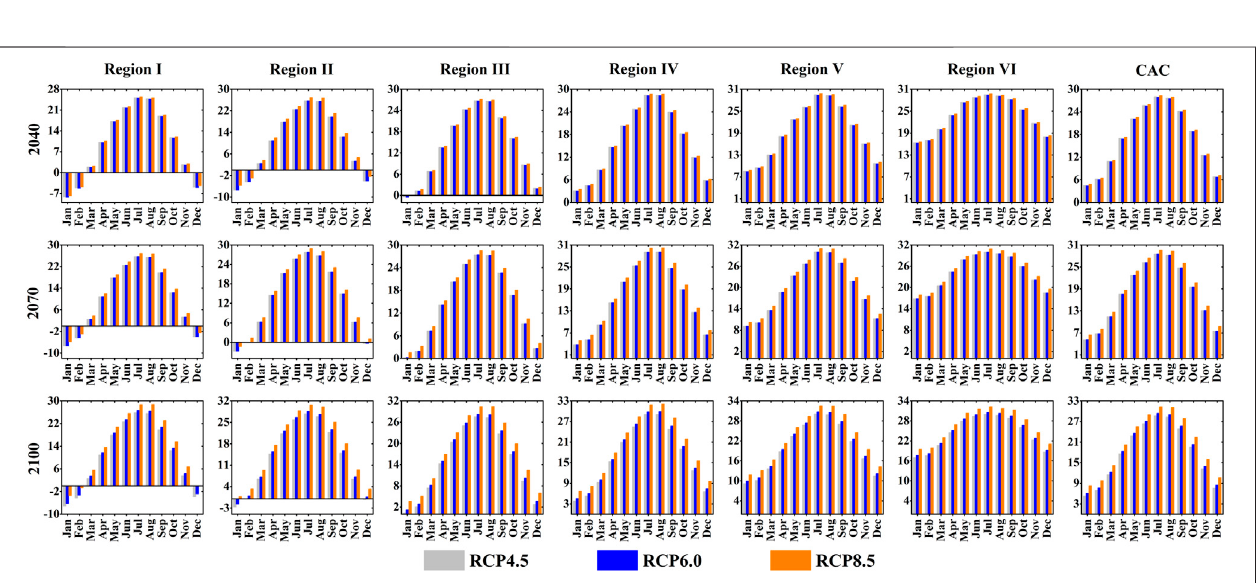
Frontiers in Environmental Science |